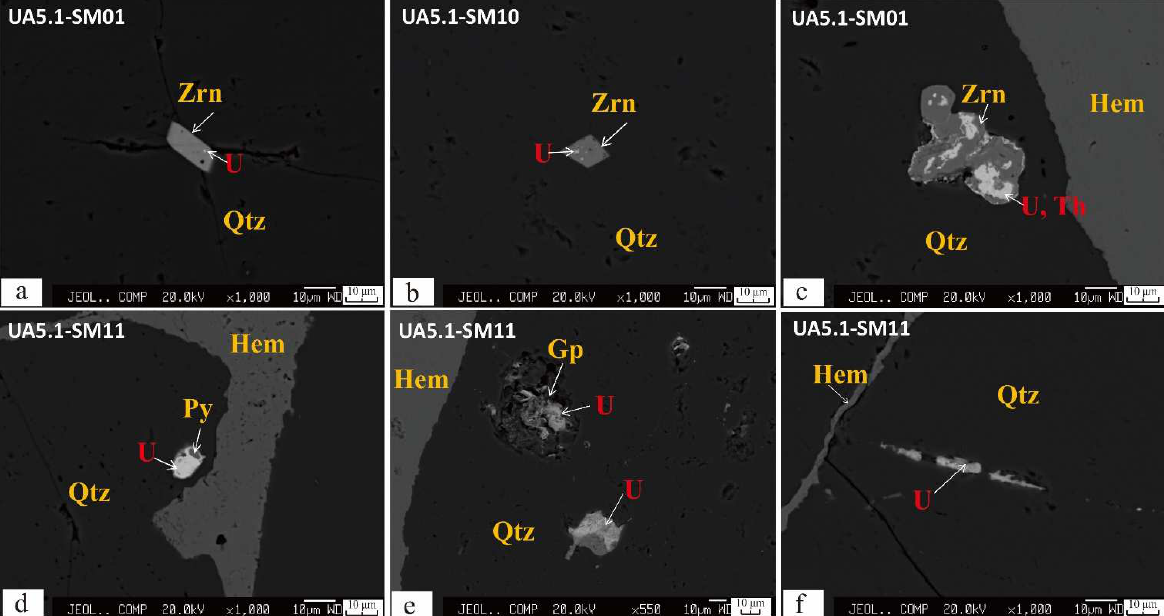
Figure 8. Existence form of uranium minerals in the Wajid Sandstone. ( a , b ) Zircon minerals contain a small amount of uranium; ( c ) Uranium and thorium are wrapped in zircon; ( d ) Uranium is adsorbed by pyrite on the surface of quartz; ( e , f ) Uranium occur in fissures of gypsum and quartz. Qtz—quartz; Zrn—zircon; U-uranium; Th—thorium; Hem—hematite; Py—pyrite; Table 4. Contents of elements (in wt.%) of EPMA data in ferruginous sandstone.